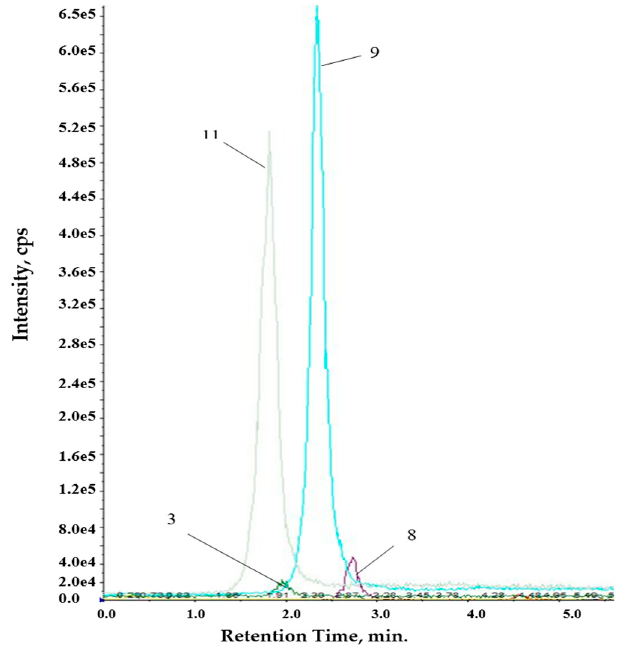
Figure 3. Chromatogram for aqueous